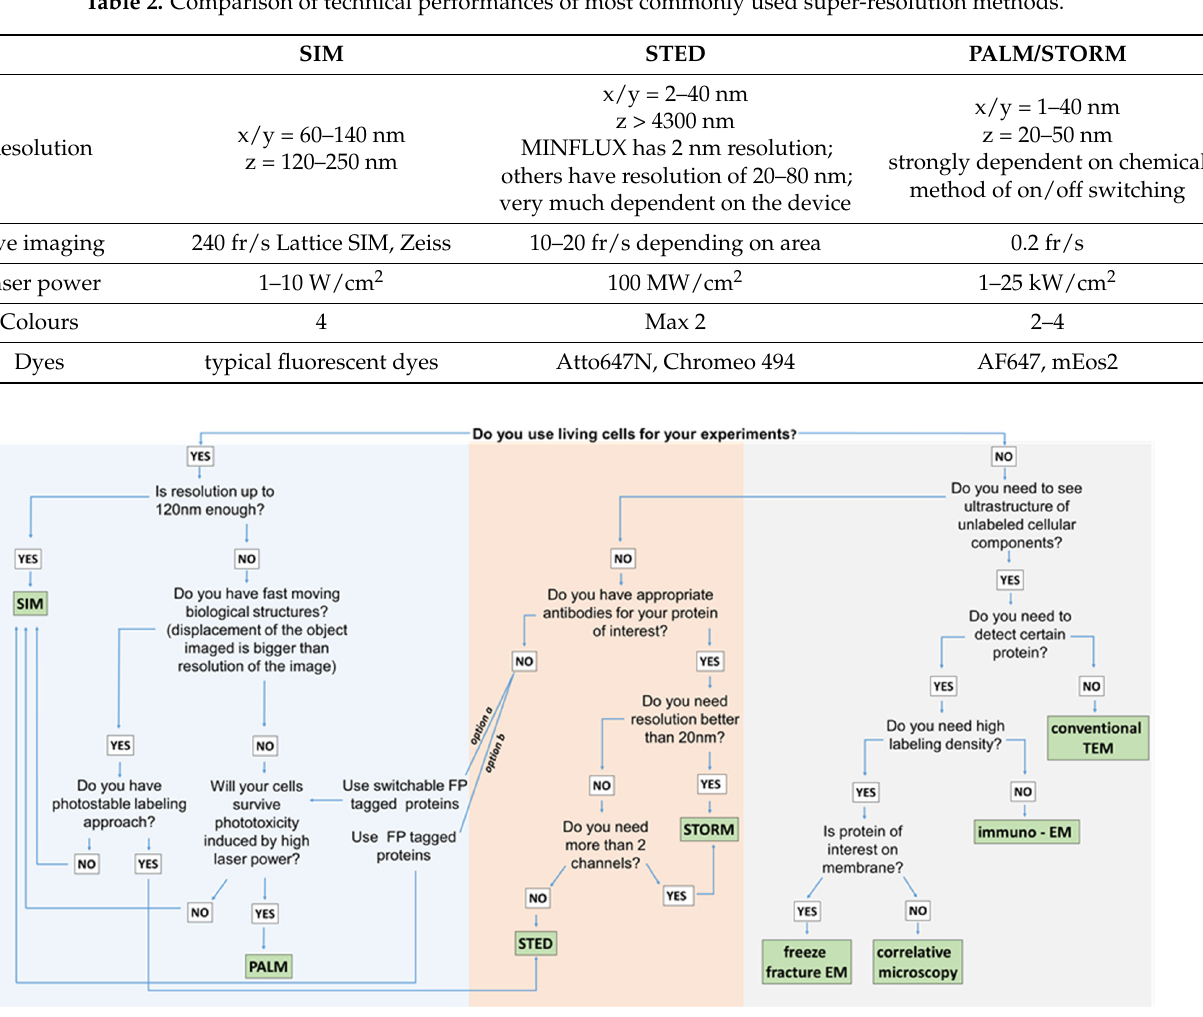
Figure 3. Guidelines for choosing appropriate visualization methods (SIM—structured illumination microscopy; PALM—photo-activated localization microscopy; STED—stimulated emission depletion microscopy; STORM—stochastic optical reconstruction microscopy; EM—electron microscopy; TEM—transmission electron microscopy).